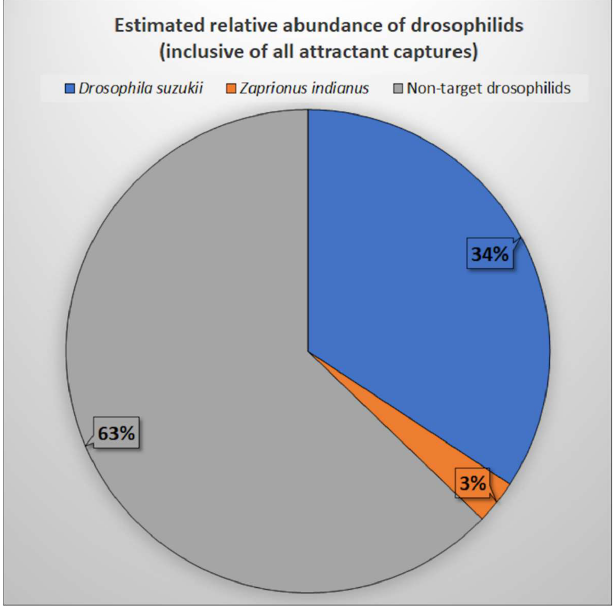
Figure 12. Estimated relative abundance of drosophilids.